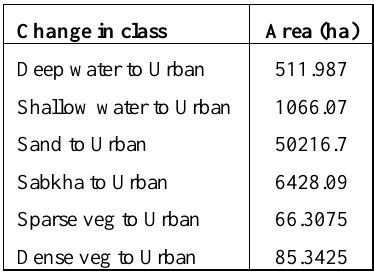
Table 2 . Change in Non-Urban areas to Urban areas in hectares (ha) between 1990 and 2022 in the study area.